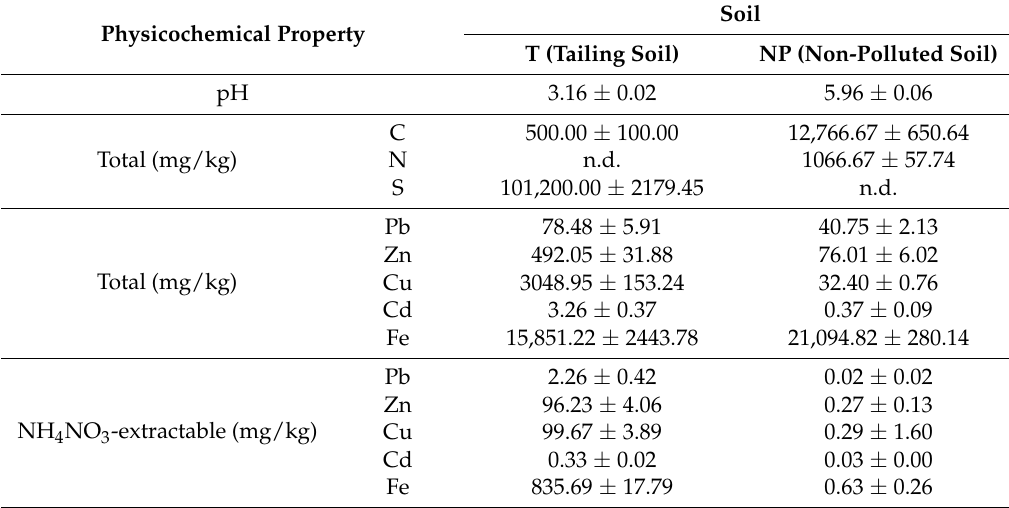
Table 1. The physicochemical properties of the